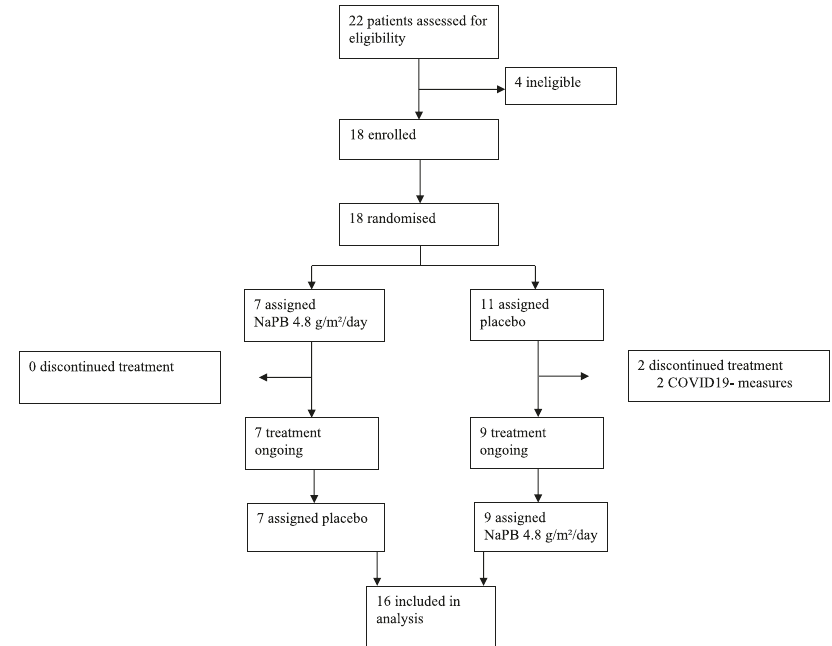
Fig. 2 Trial pro fi le. Sixteen participants completed the treatment and were included in analysis. Two patients discontinued treatment prematurely due to